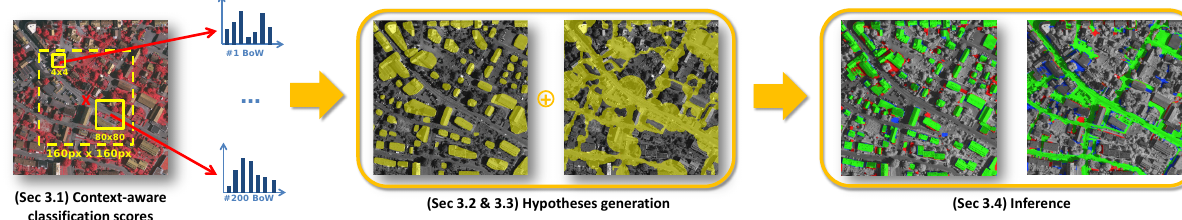
Figure 1. Given an input image, our method first classifies pixels into multiple labels (Sec. 3.1). Next, an over-complete set of building and road candidates is generated (Sec. 3.3 & 3.2). Finally, the candidates are pruned to an optimal subset (Sec.